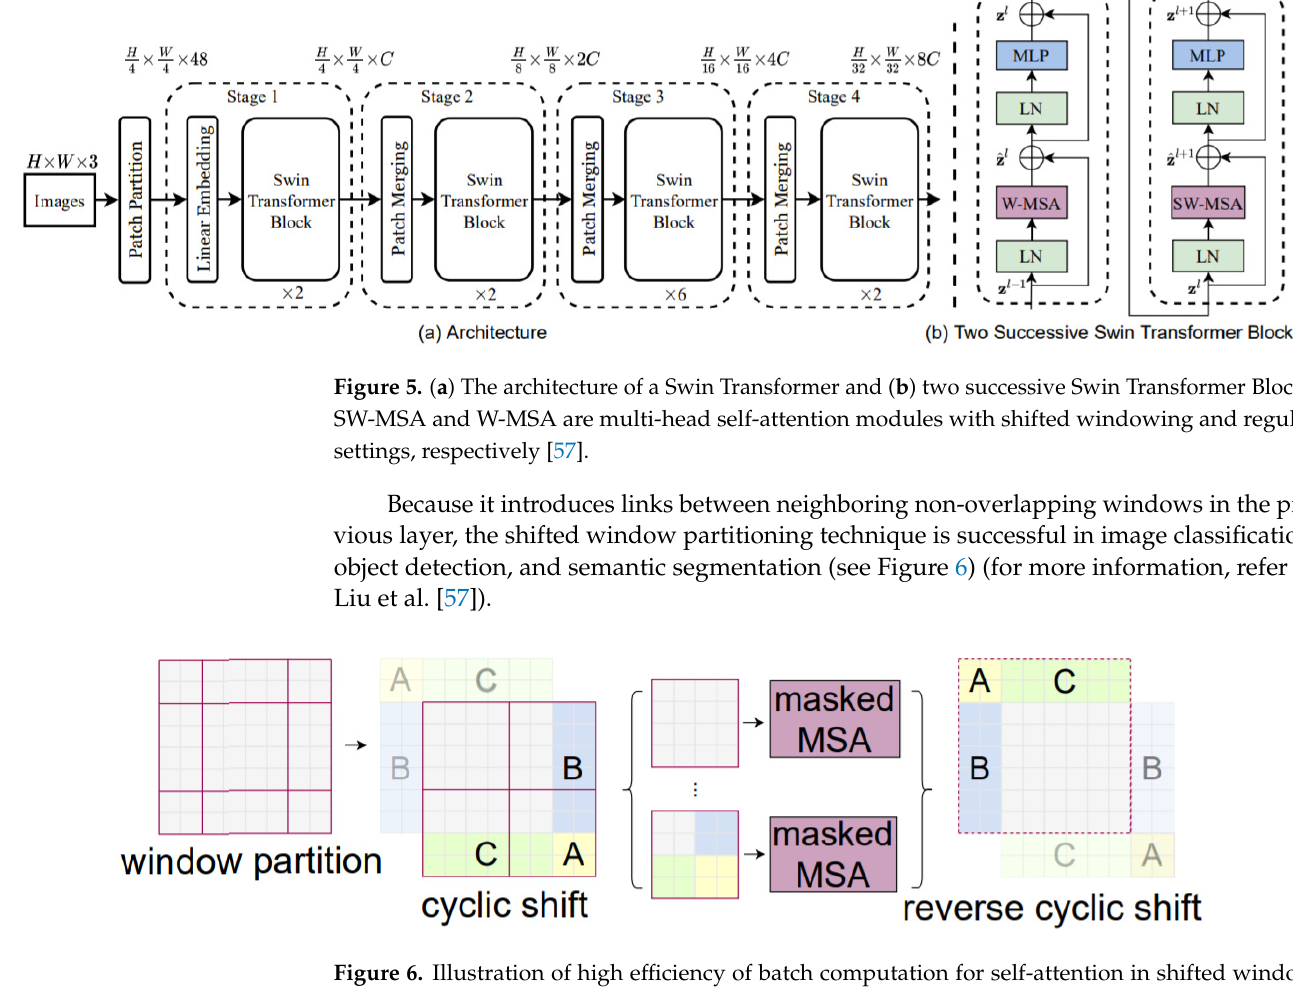
Figure 6. Illustration of high efficiency of batch computation for self-attention in shifted window partitioning [57].